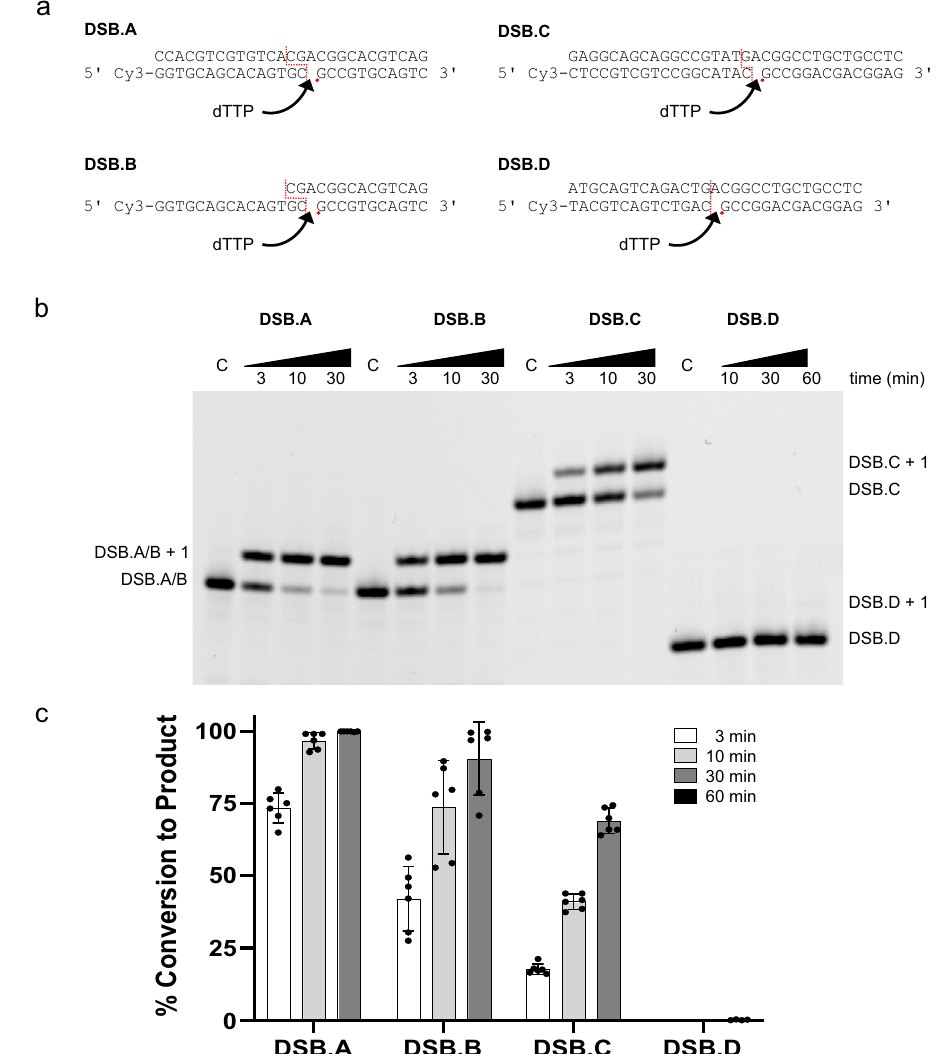
Fig. 2 Pol λ synapses and fi lls a variety of DSB end-con fi gurations. a DSB substrates utilized for in vitro gap- fi lling assays. All substrates include a 5 ʹ -Cy3- labeled upstream primer and a 5 ʹ -phosphorylated (indicated by red dot) downstream primer. The break site location is indicated by a dashed red line. b Gap- fi lling activity of full-length wildtype Pol λ on the different DSB end con fi gurations examined in this study. c Quantifcation of gap- fi lling pro fi ciency. The mean conversion from substrate to product is shown for each substrate, and the error bars correspond to the standard deviation. Reactions were prepared as biological replicates, with n = 6 for DSB substrates A – C, and n = 4 for DSB substrate D. The % conversion for the DSB.D substrate was less than 0.5% for all replicates, after a 60 min